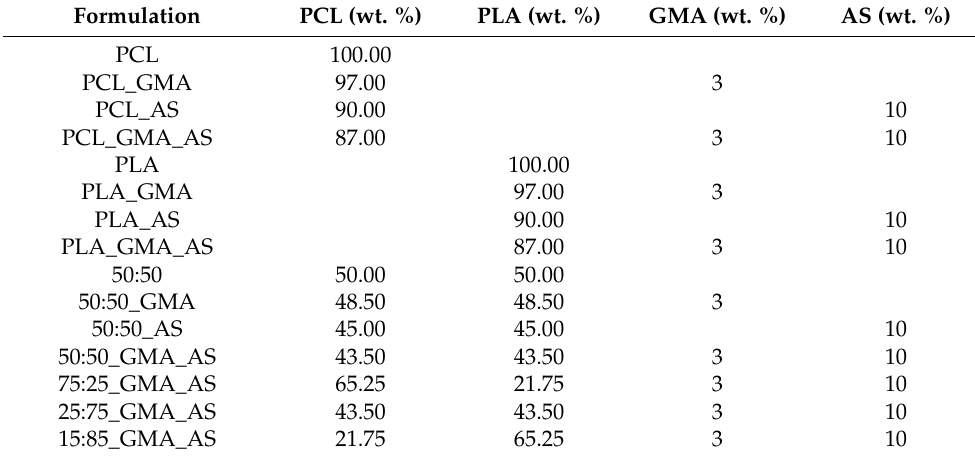
Table 1. Formulations obtained in this